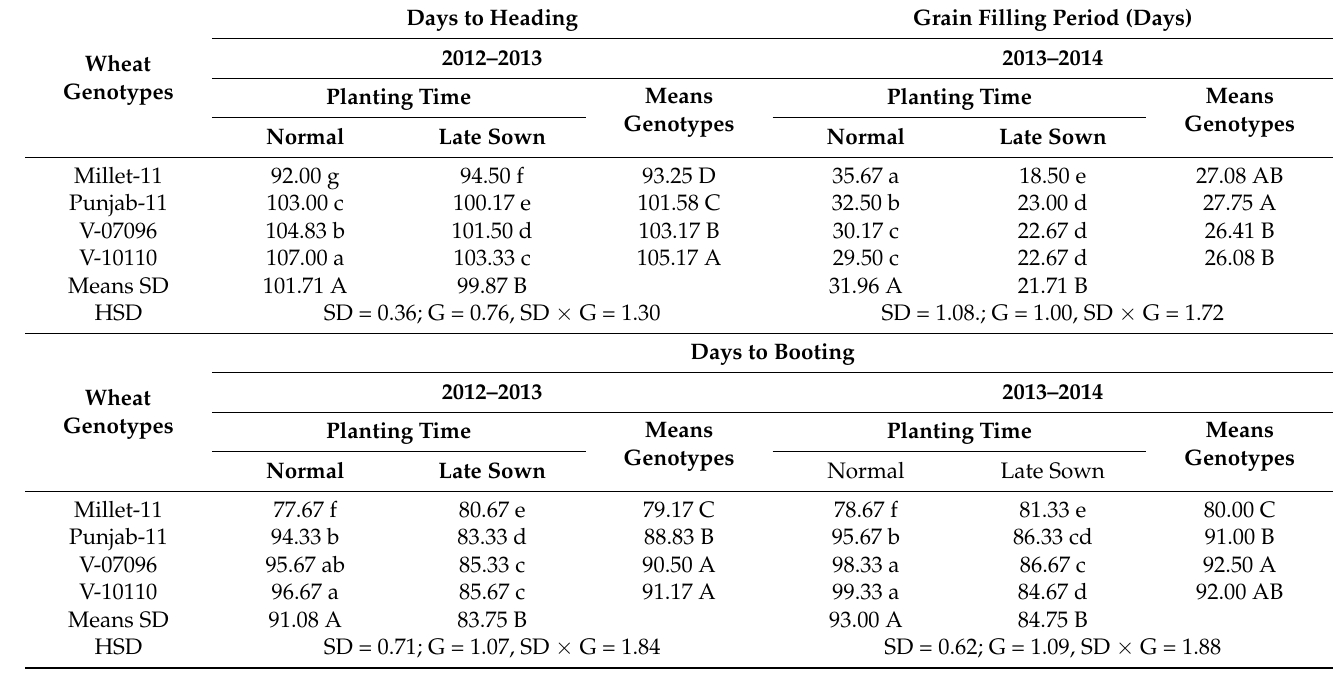
Table 1. Mean comparison for crop phenology and physiological traits in wheat genotypes under late sown condition.